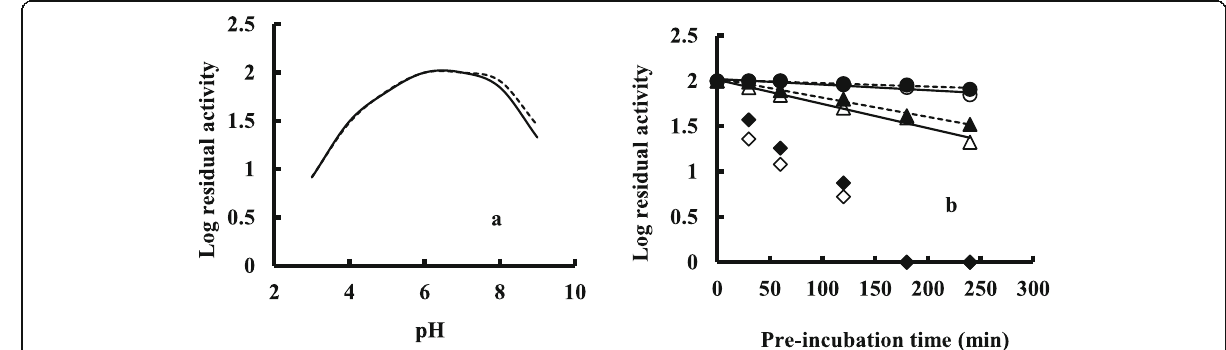
Fig. 5 Effect of pH on the stability ( a ) of the crude exo -polygalacturonase, produced by Pleurotus ostreatus in submerged ( − ) or solid-state ( … ) fermentation and the effect of temperature on the stability ( b ) of the crude exo -polygalacturonase, produced by Pleurotus ostreatus in submerged [( ○ )- 30 °C, ( Δ )- 50 °C, ( ◊ )- 70 °C, ( − )] or solid-state [( ● )- 30 °C, ( ▲ )- 50 °C, ()- 70 °C, ( … )] fermentation. Data presented were the mean values of the 3 sets of experiments (standard deviation of the relative and residual enzyme activity were within ±8% and ±7 %